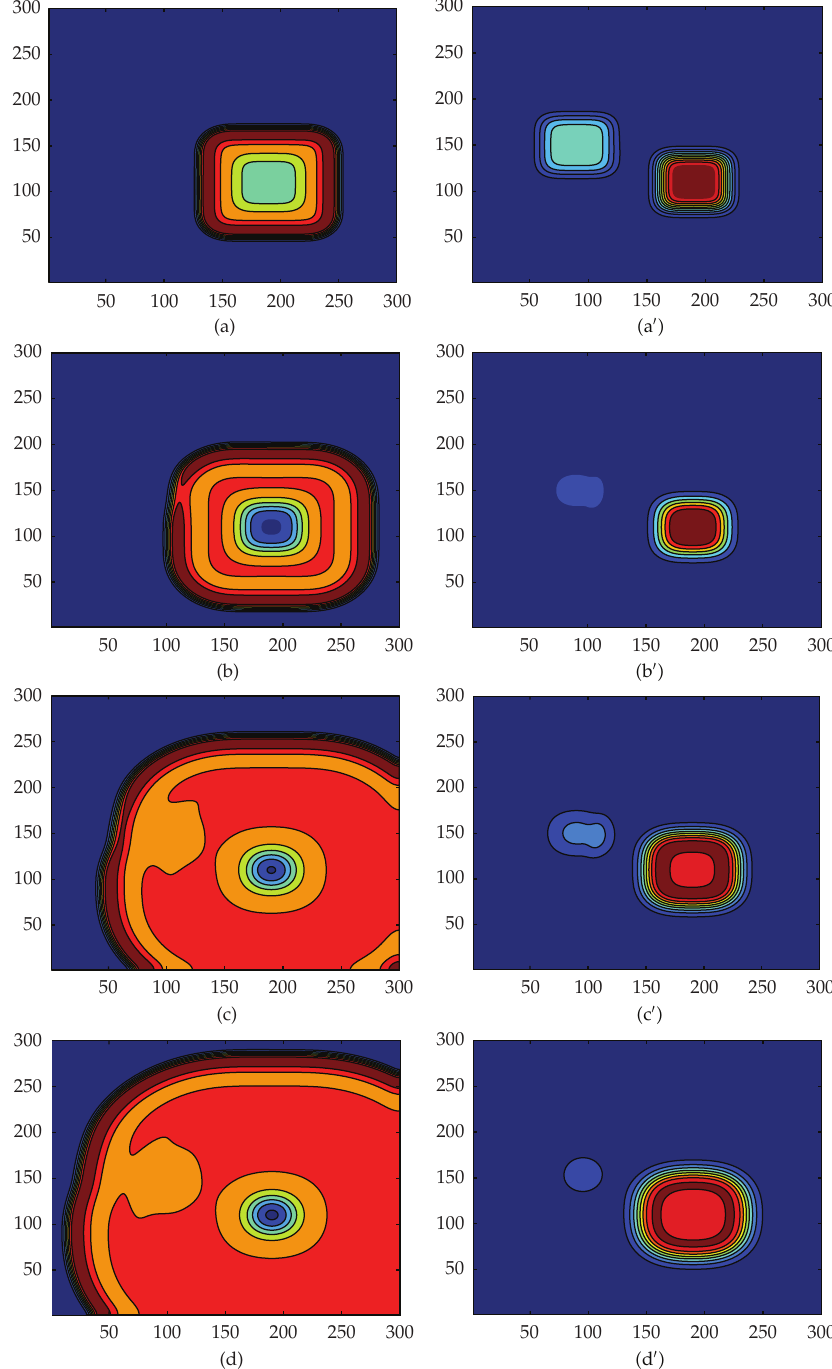
fronts if they feed on resources at different trophic levels